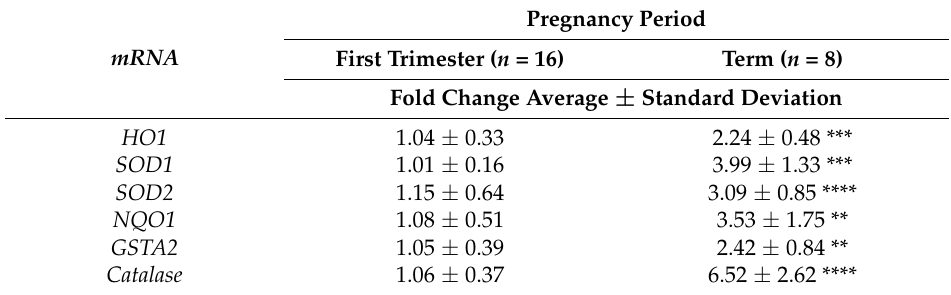
The means (long horizontal lines) and standard deviations (short horizontal lines) of 16 or eight independent experiments are shown. qRT-PCR data are normalized to the geometric mean of HPRT , RPL13 , and 18S transcripts, and reported to CK7 ( KRT7 ) ** p < 0.01; *** p < 0.001; **** p <